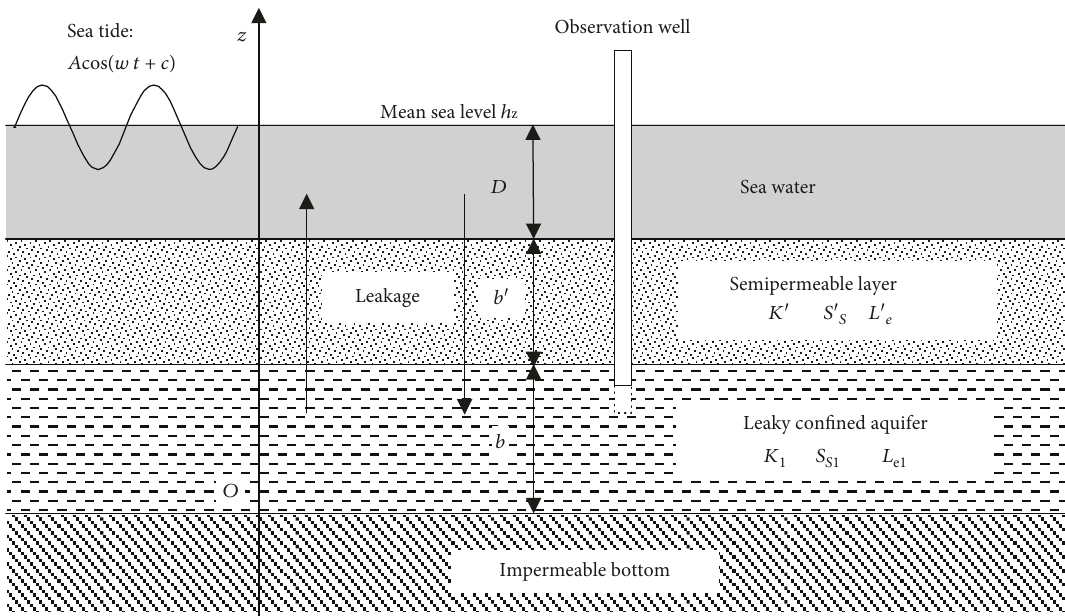
Figure 1: Schematic of a submarine leaky con fi ned aquifer